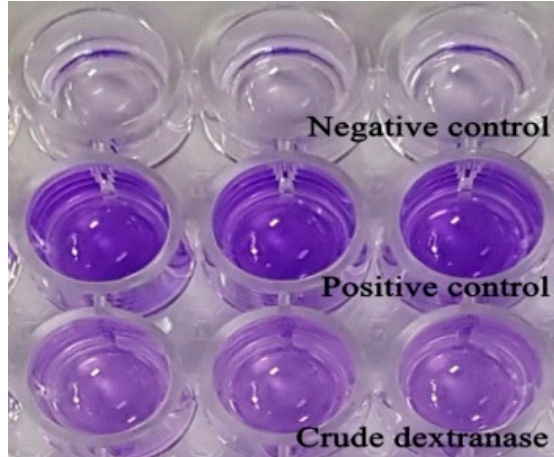
Figure A2. The regular spherical shape of alginate beads containing encapsulated fungal dextranase roquefortii TISTR 3511 and diameter ( mm ). from P .